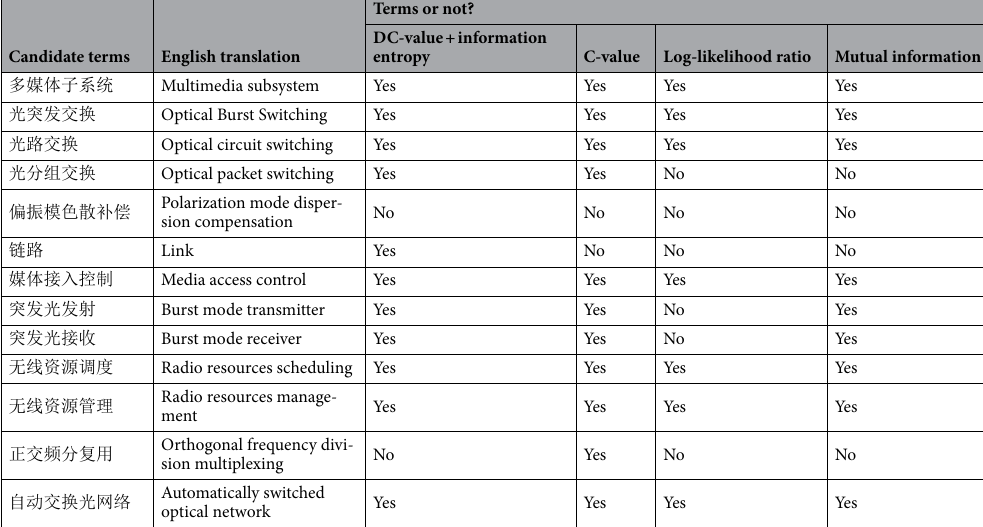
Table 4. Technical terminology extraction results of four methods.